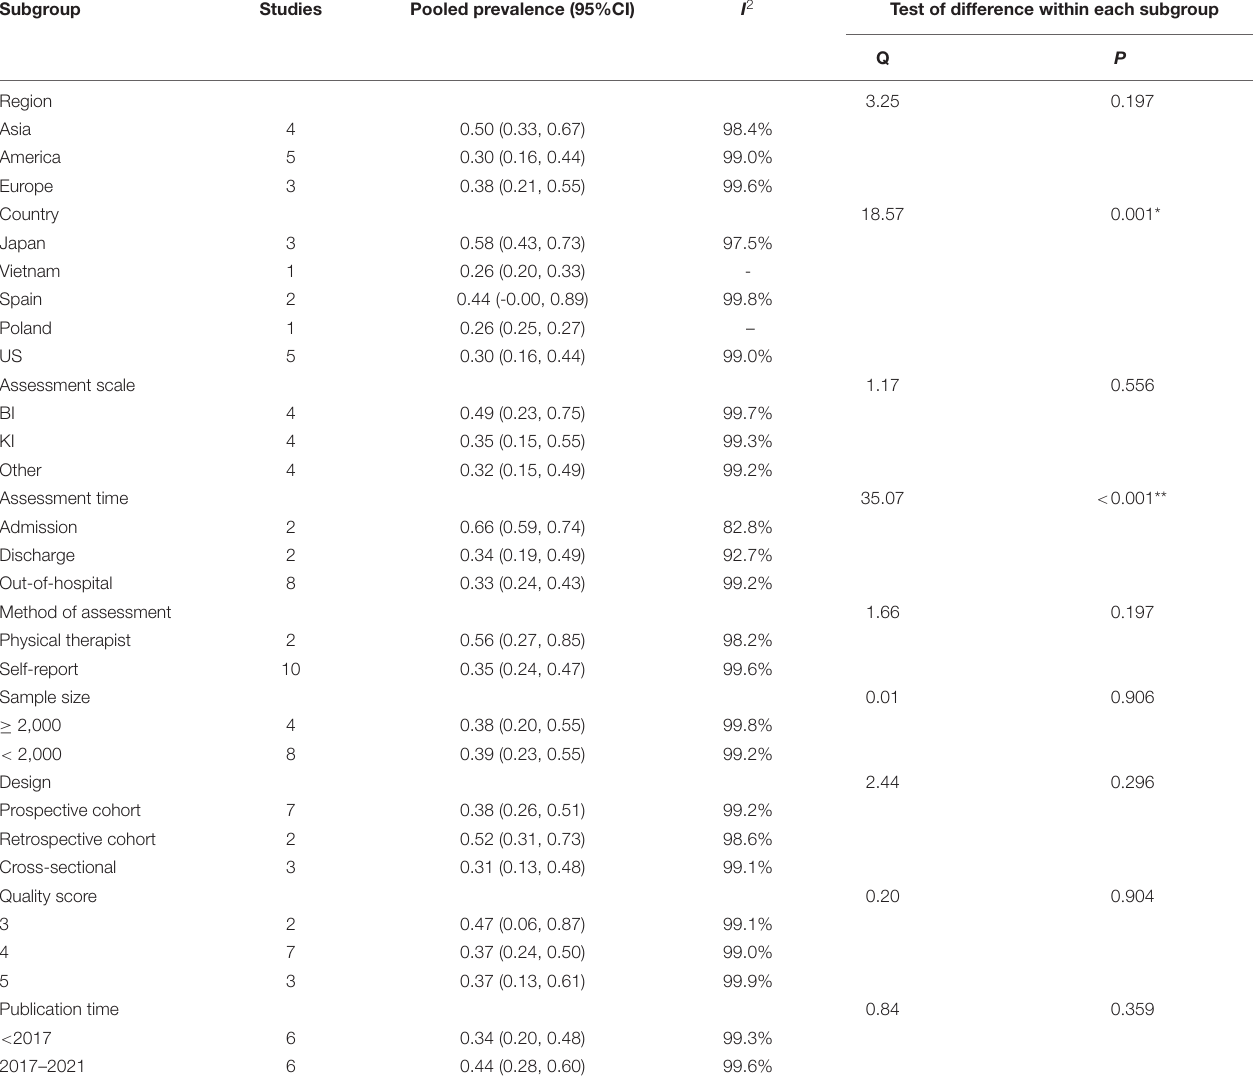
TABLE 2 | Subgroup analysis of the pooled prevalence.